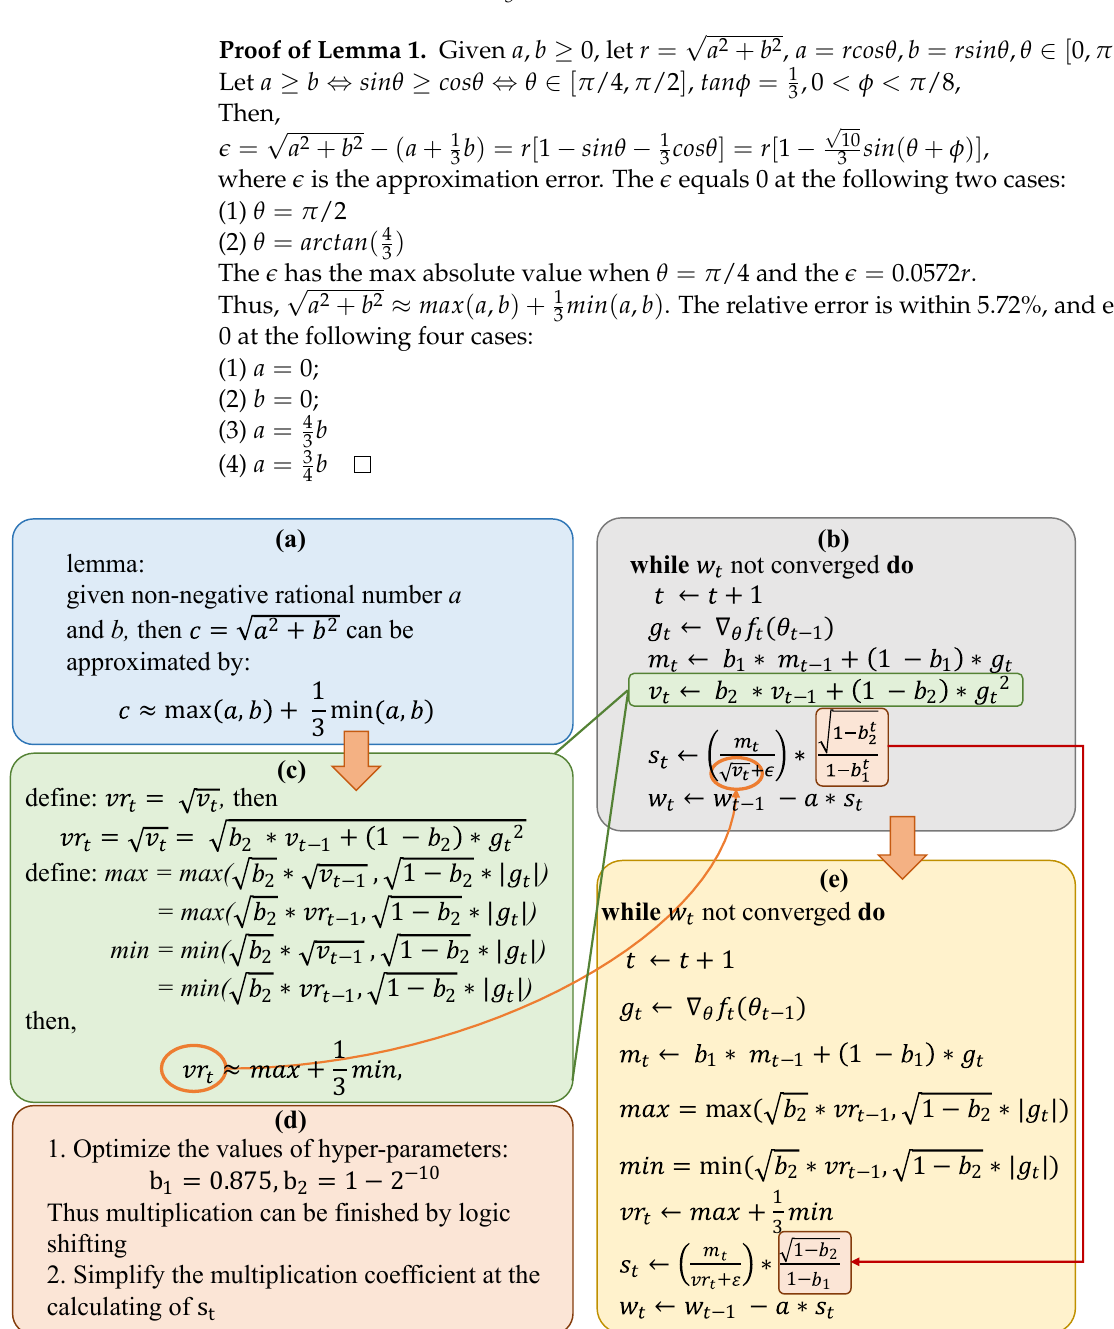
Figure 3. Proposed optimization of Efficient-ADAM. Subgraph ( a ) is the introduced lemma. Subgraph ( b ) is the workflow of the original ADAM. Subgraph ( c ) is the proposed approximation. Subgraph ( d ) is the further optimization of the hyper-parameters and calculation. Subgraph ( e ) is the workflow of the proposed